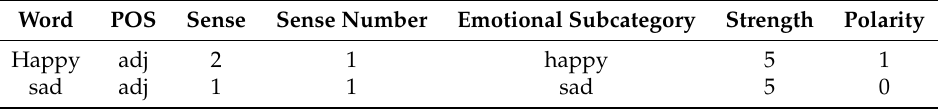
Table 2. Examples of the emotional vocabulary ontology format. Part of speech